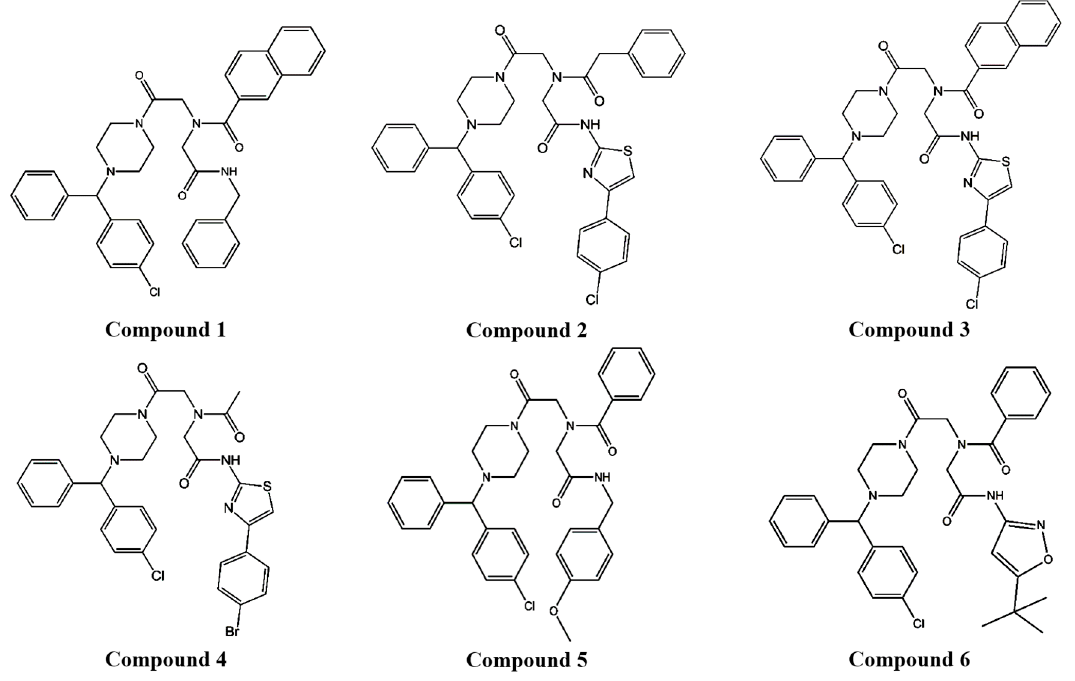
Figure 1. The structures of piperazine derivatives.